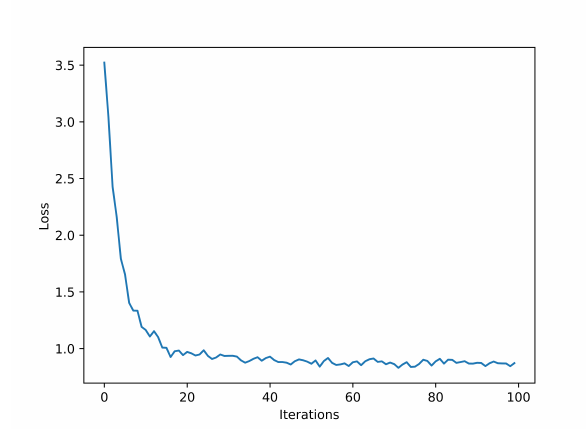
Figure 2. Loss versus iterations (epoch) graph for the